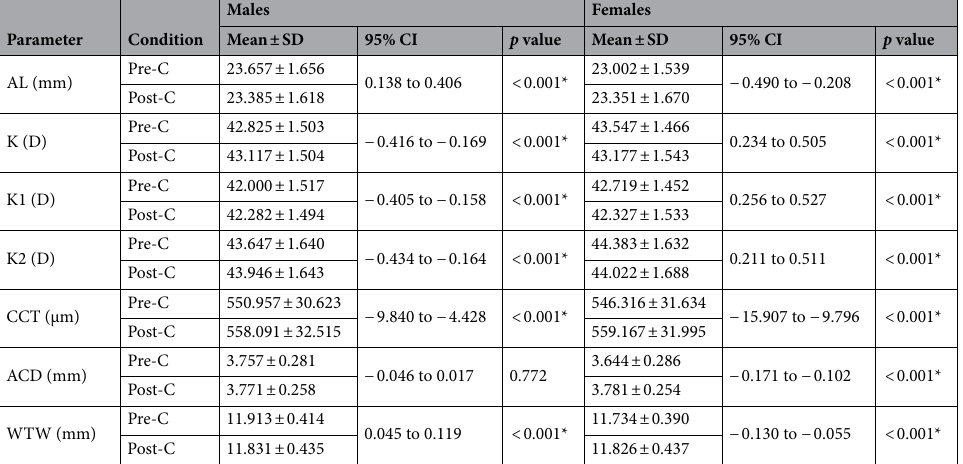
Table 5. Statistical analysis of the mean, SD, and 95% CI of ocular biological characteristics of the subjects pre- and postcycloplegia in group A (males) and group B (females). AL axial length, K mean keratometry, K1 flat keratometry, K2 steep keratometry, CCT central corneal thickness, ACD anterior chamber depth; WTW white-to-white distance; D dioptre; C cycloplegia, SD standard deviation; CI confidence interval. * p < 0.05 was considered statistically